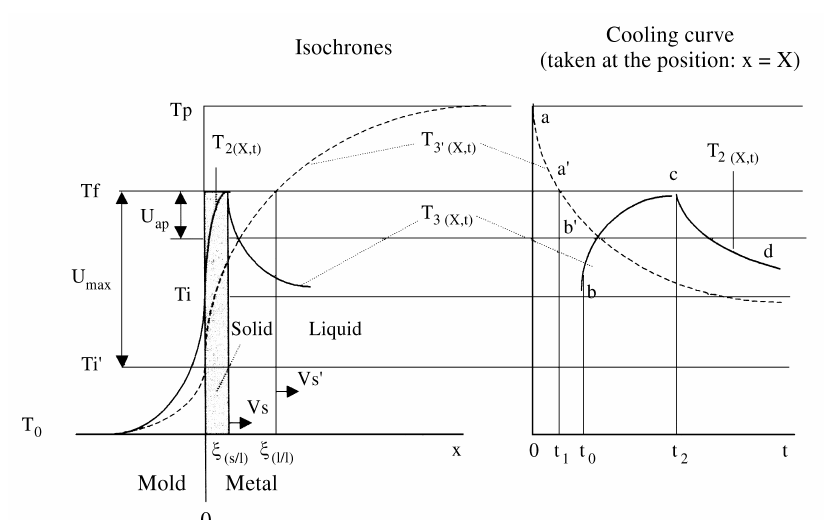
Figure 4. Maximum and apparent undercoolings, superheated / supercooled liquid (l /l), solid / liquid (s / l) interfaces, incubation time (t 0 ) and the resulting cooling curve created by a thermal shock in a liquid metal against a cooler mold, after the nucleation’s